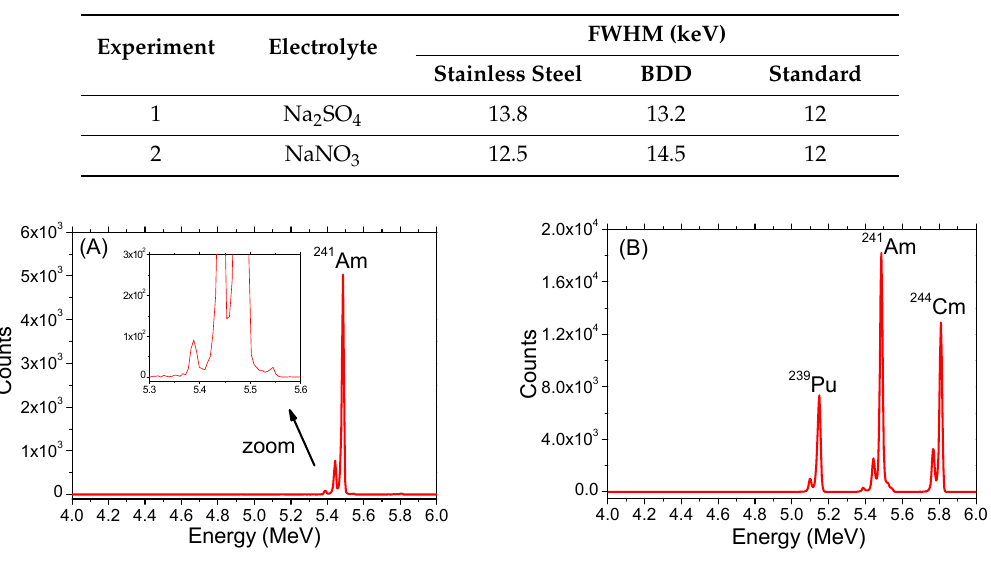
Figure 6. Typical alpha-particle spectra: ( A ) 241 Am 5.96 Bq electro-precipitated in 0.3 M Na 2 SO 4 electrolyte solution at pH 3.85 with a current density of 8 mA.cm − 2 onto BDD during 90 min; ( B ) mixture of 239 Pu 5.13 Bq, 241 Am 5.96 Bq and 244 Cm 4.40 Bq electro-precipitated onto doped diamond substrate for 120 min in 0.3 M Na 2 SO 4 pH 4.0 electrolyte solution with a current density of 5 mA.cm − 2 .